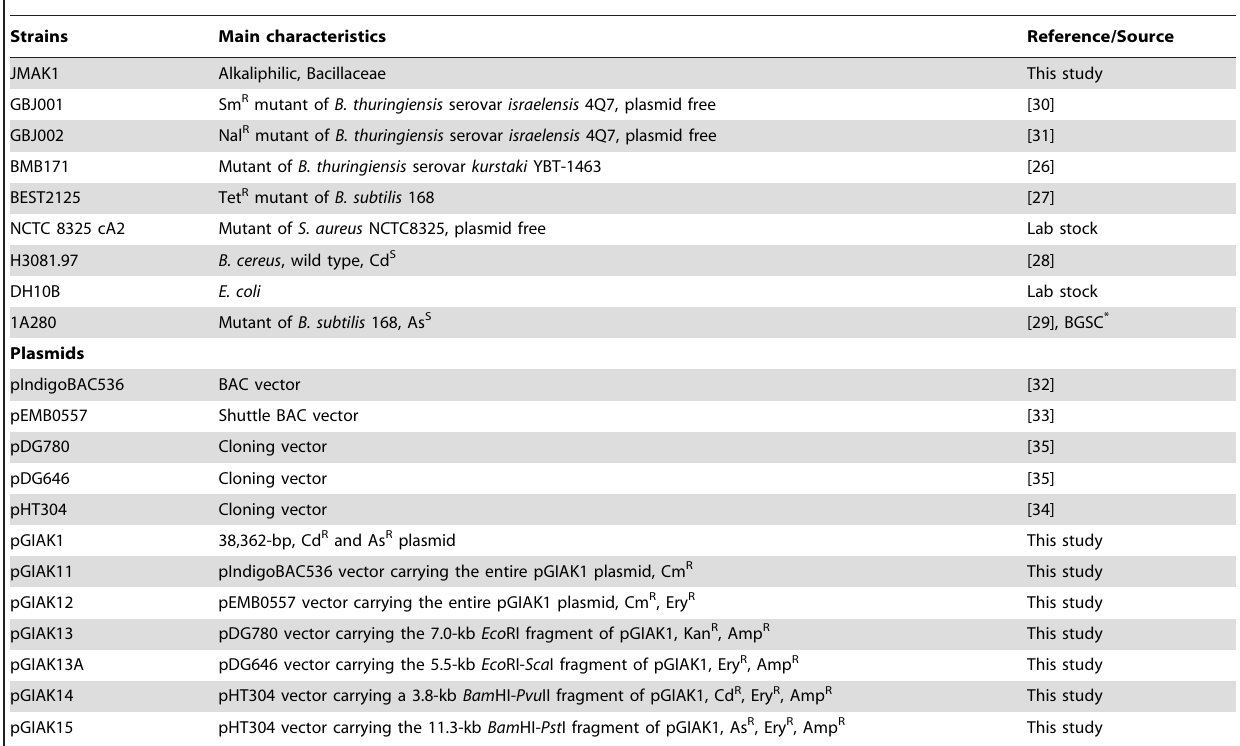
Table 1. Strains and plasmids used in this